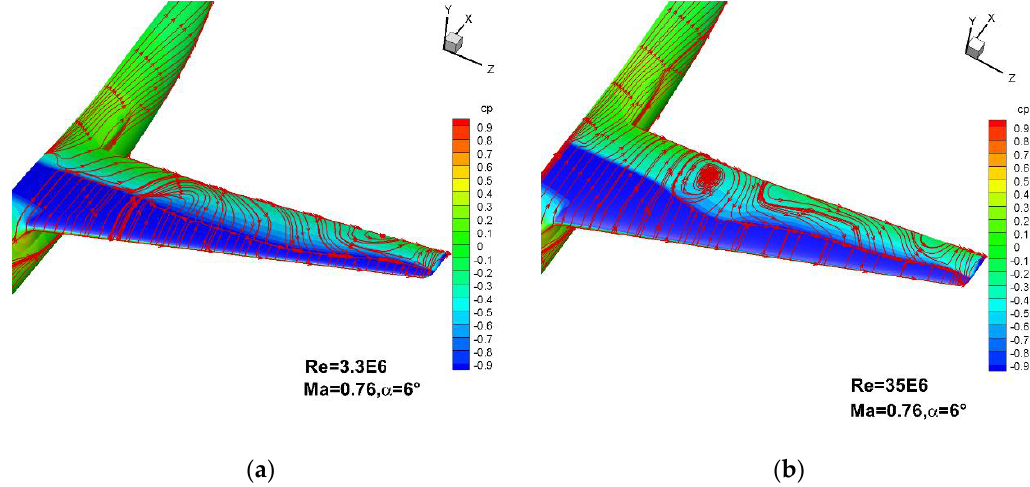
Figure 14. Numerical flow structures at different Reynolds numbers (M = 0.76, α = 6°): ( a ) Re = 3.3 × 10 6 ; ( b ) Re = 35 × 10 6 .